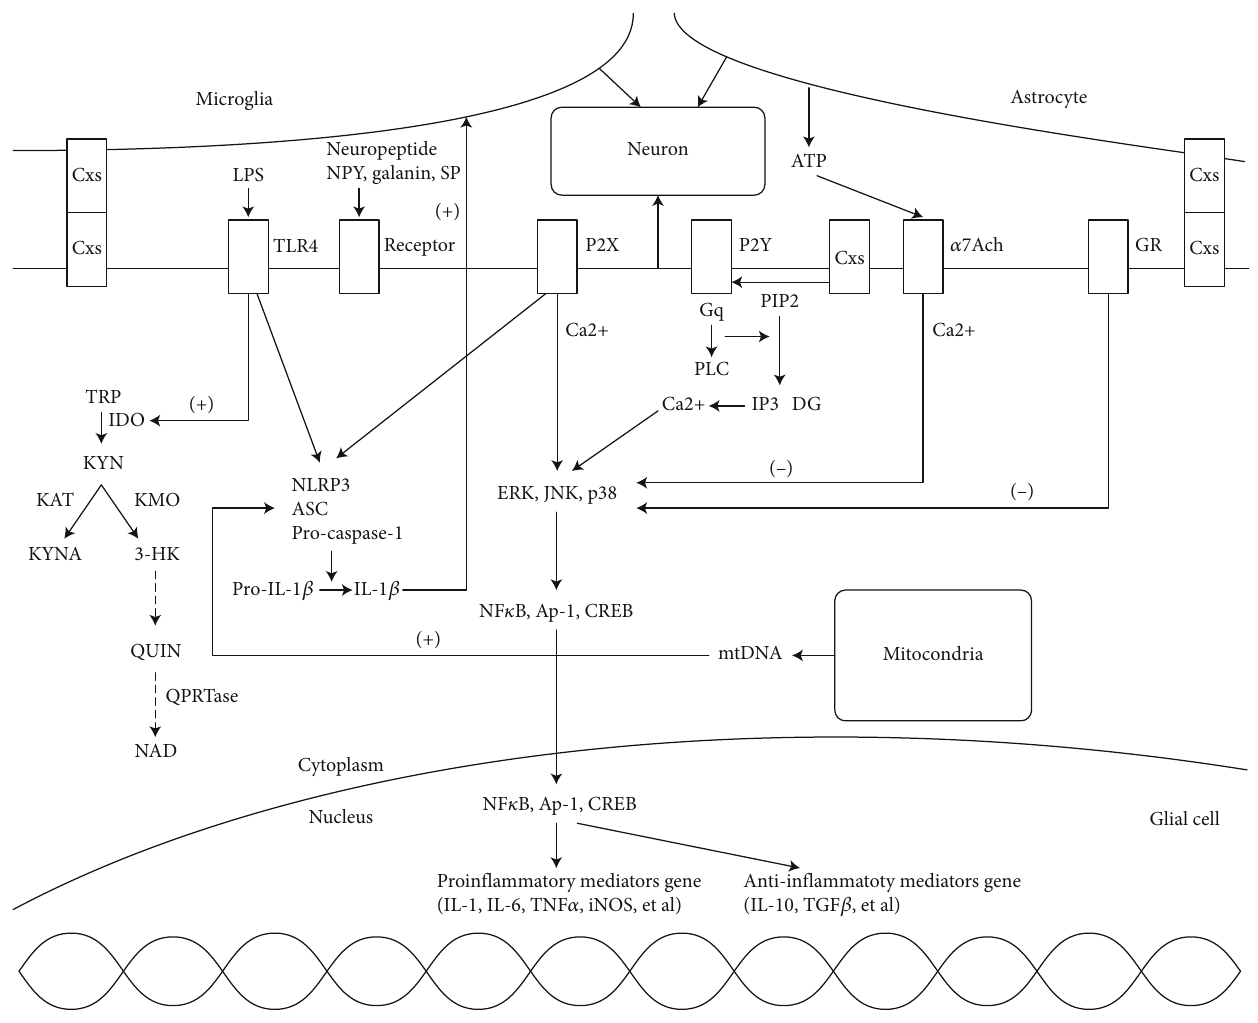
Figure 1: A schematic graph demonstrates the role of glial cells and the relevant signaling pathway. The surrounding microglia (upper left) and astrocyte (upper right) impact the function of neuron (middle) in multiple ways. The nuclear mechanisms of some of the pathways are graphed at the